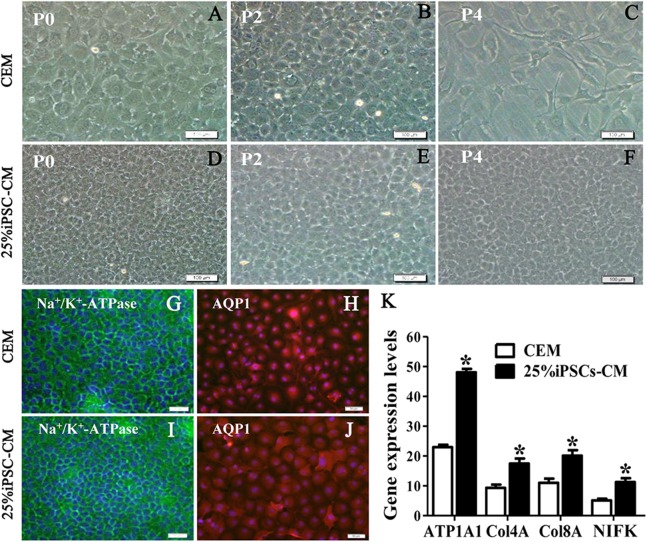
The maintenance of CEC phenotype after treatment with iPSC-CM.Morphological change of B-CECs in P0 (A, D), P2 (B, E), and P4 (C, F) under phase-contrast microscopy. Scale bar: 200 μm. (G–J) The protein expression of Na+-K+-ATPase and AQP1 by immunocytochemistry. Scale bar: 100 μm. Immunofluorescence staining showed that the 25% iPSC-CM group and the CEM group both expressed the same endothelial marker proteins, Na+/K+-ATPase, and AQP1. (K) The mRNA expression of ATP1A1, Col4A, Col8A, and NIFK by qPCR. The qPCR showed that the 25% iPSC-CM group had a higher expression than the CEM group, both in the endothelial marker genes ATP1A1, Col4A, Col8A and in the proliferation-related gene NIFK, and the difference was statistically significant (*P < 0.05 was considered statistically significant; versus CEM group, n = 3). Scale bar: (A) 100 μm; (B) 50 μm.